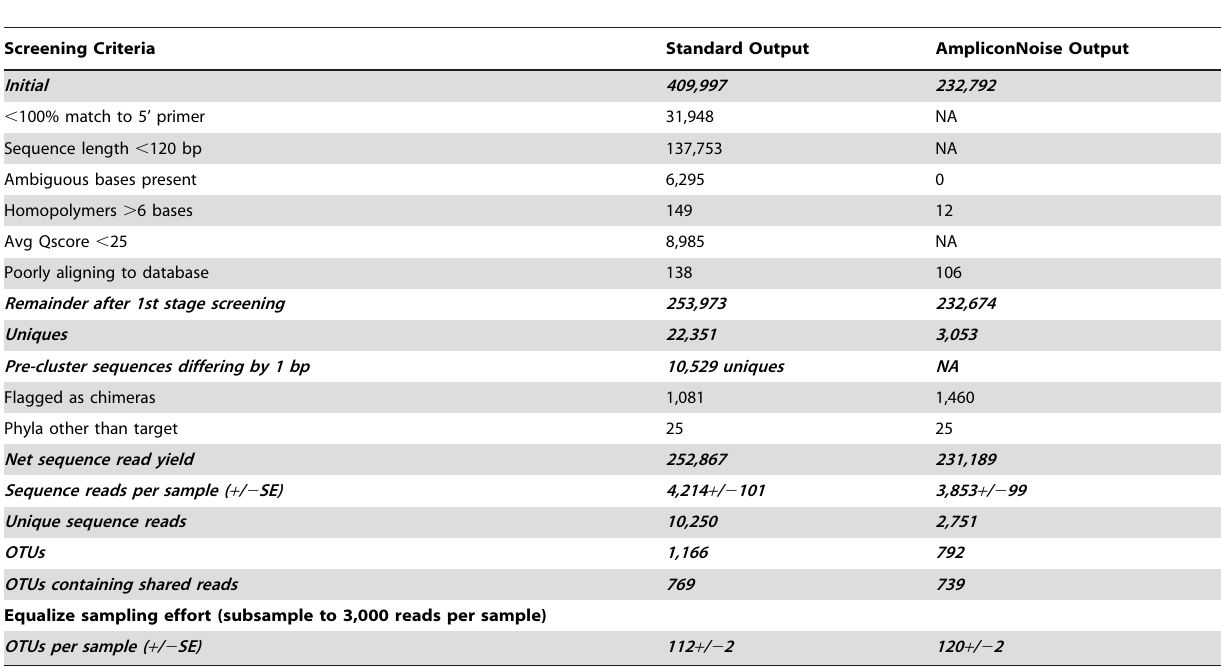
Table 1. Number of sequences failing quality screening criteria and total number of sequences remaining (bold, italics), for standard processing pipeline and for AmpliconNoise